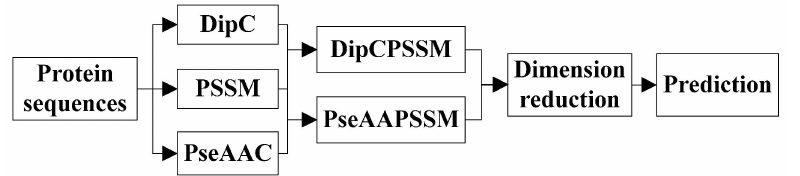
Figure 1. A flowchart of the prediction